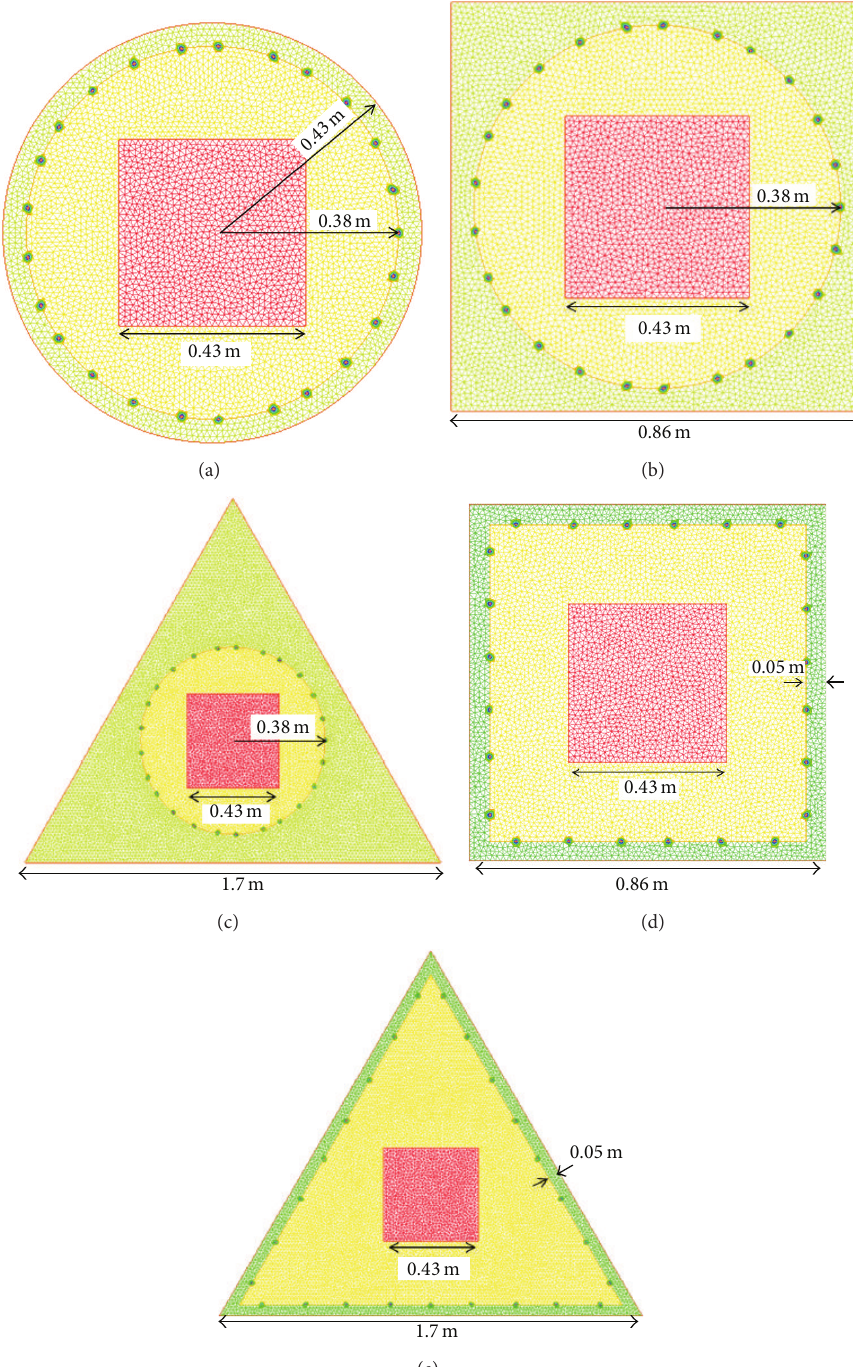
Figure 1: Considered measurement configurations: ((a), (b), and (c)) measurement configurations with probes on a circle located around the imaging domain (configuration A); ((d), (e)) measurement configurations with probes on lines parallel to the edges of the PEC at a distance equal to 𝜆 𝑏 / 4 (configuration